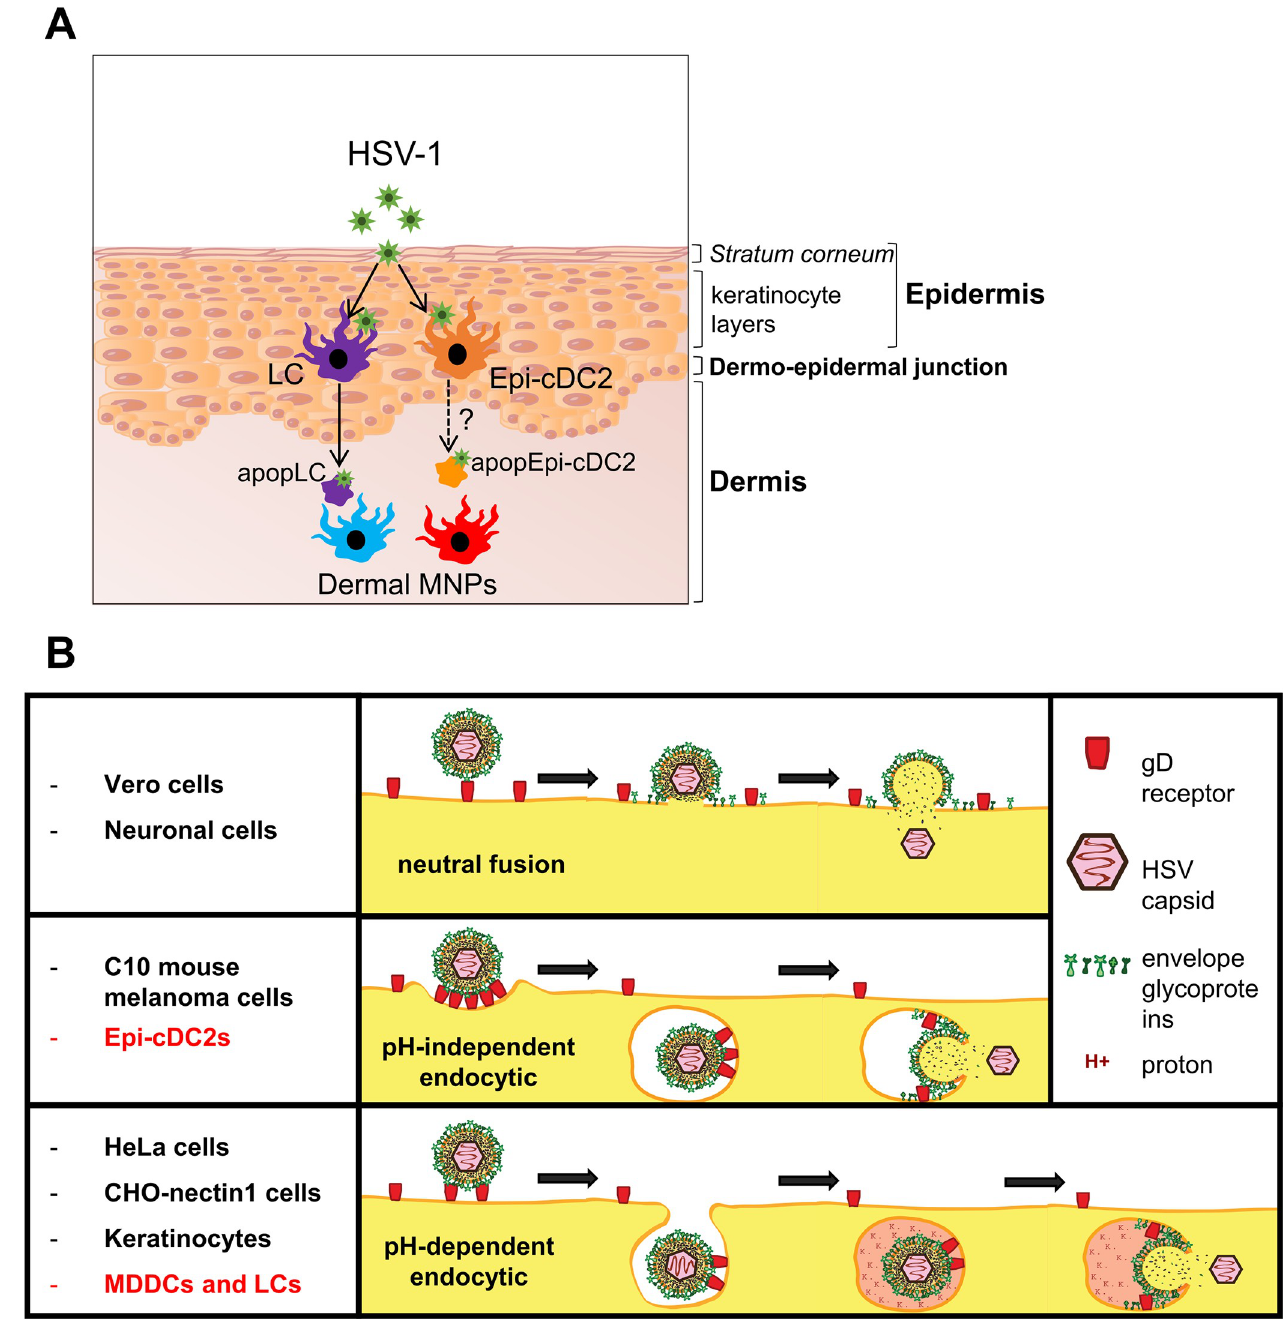
Fig 10. The HSV viral relay between epidermal and dermal MNPs and HSV entry pathways into them compared to other target cells. (A) HSV enters skin where the stratum corneum is damaged or absent and infects LCs and Epi-cDC2s, located in the epidermis. Upon HSV infection both cell types undergo apoptosis. HSV infected LCs migrate to the dermis, where they cluster with and are taken up by dermal MNPs, which may go on to present the HSV antigens to T cells. Whether HSV infected apoptotic Epi-cDC2s also migrate to the dermis and are taken up by dermal MNPs, thereby contributing to the HSV viral relay, is being investigated. (B) HSV enters cells via different pathways depending on the host cell type. HSV enters Vero and neuronal cells by neutral fusion at the plasma membrane. A pH-independent endocytic pathway is utilised for C10 mouse melanoma cells and Epi-cDC2s, whereas a pH-dependent endocytic pathway is utilised in epithelial cells such as keratinocytes, HeLa cells and CHO-nectin 1 cells, as well as predominantly in human MDDCs and LCs.